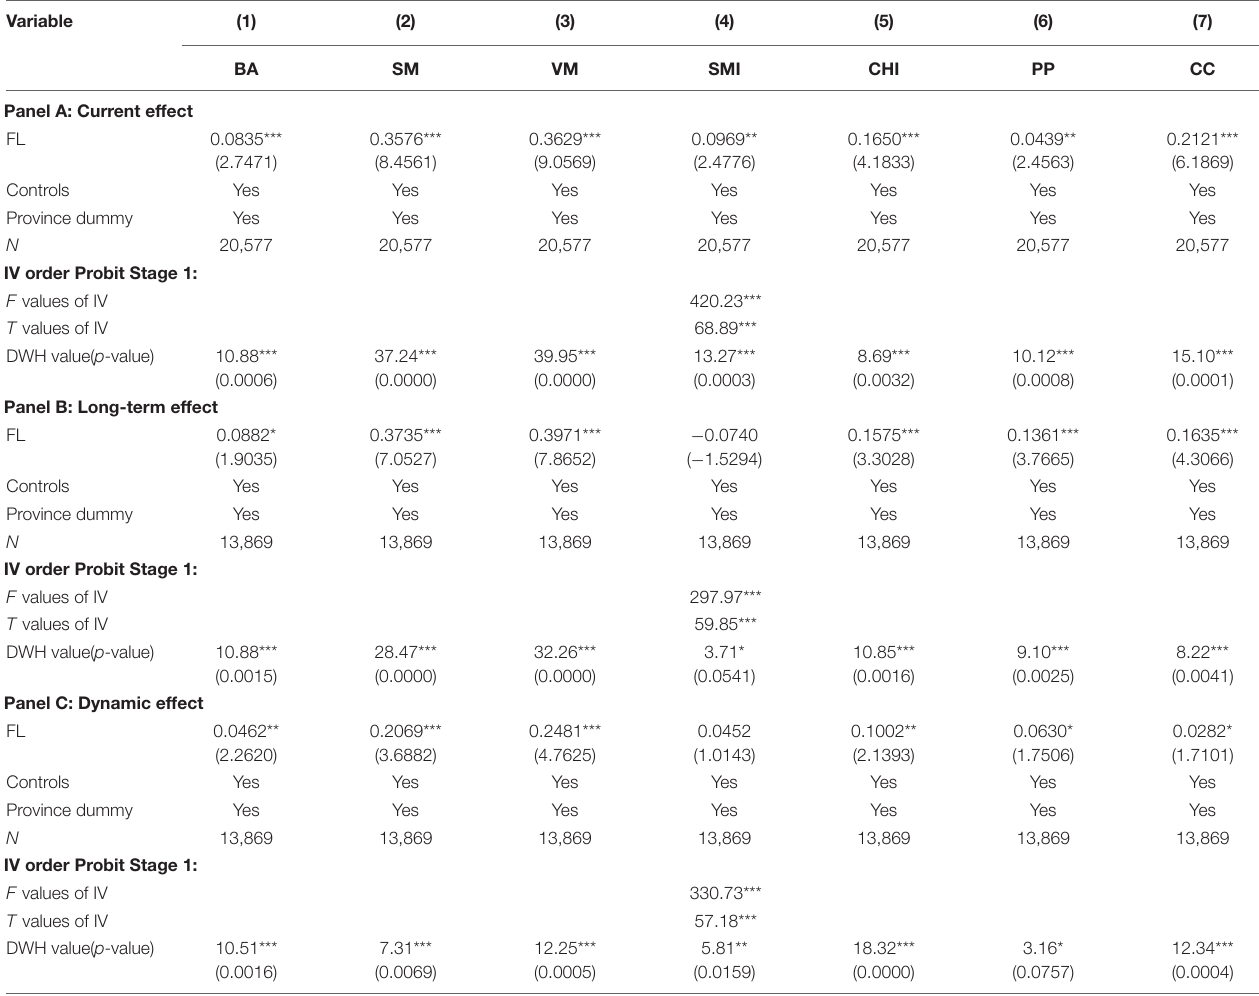
TABLE 4 | IV estimation of financial literacy and financial